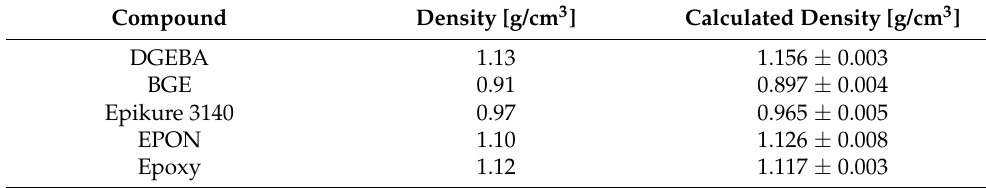
Table 3. Comparison of calculated density of epoxy constituents with manufacturer data at 25 ◦